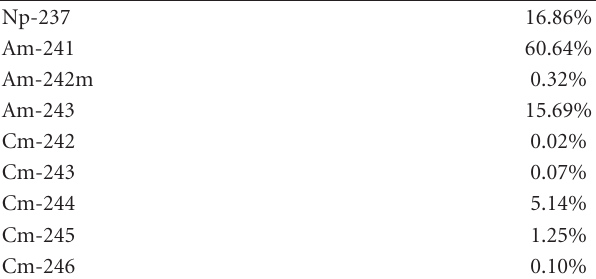
Table 4: Isotopic vector of the Minor Actinide mixture. This mixture represents an average composition expected to be available from 2016 in France